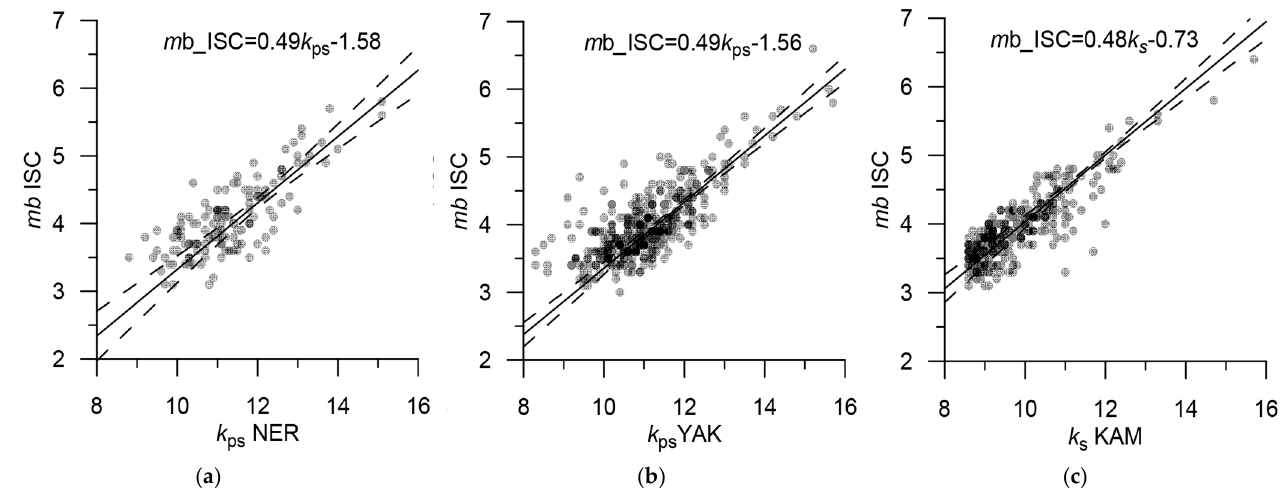
Figure 14. Correlation ratios of the energy classes K PS and K S and the magnitude mb ISC . ( a ) Northeast, K PS ; ( b ) Yakutia, K PS ; and ( c ) Kamchatka, K S . The dashed lines show 95% confidence intervals.